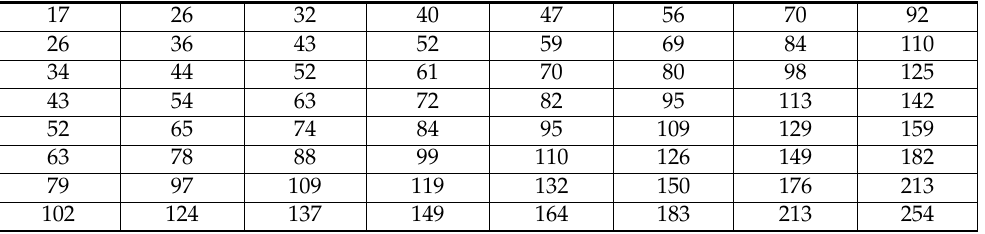
Table 4. A custom quantization table proposed in [48] for the JPEG algorithm with chroma subsam-